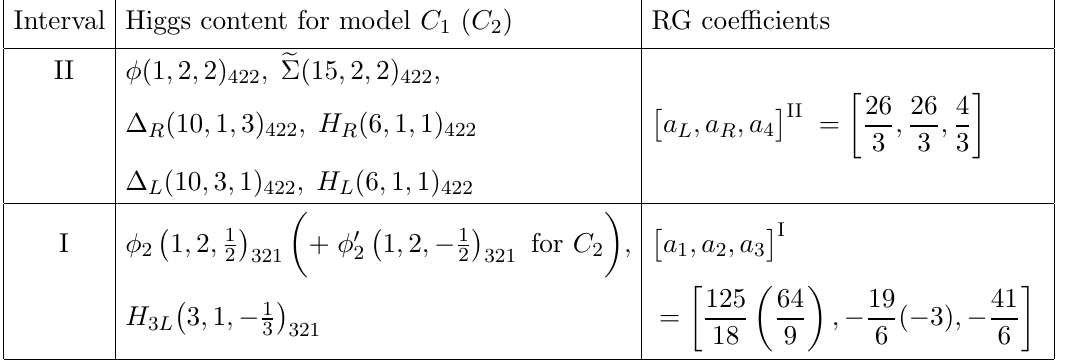
Table 5 . The Higgs content and the RG coe(cid:14)cients in the energy intervals for model C 1 ; 2 . Recall that all the (cid:12)elds above are complex.